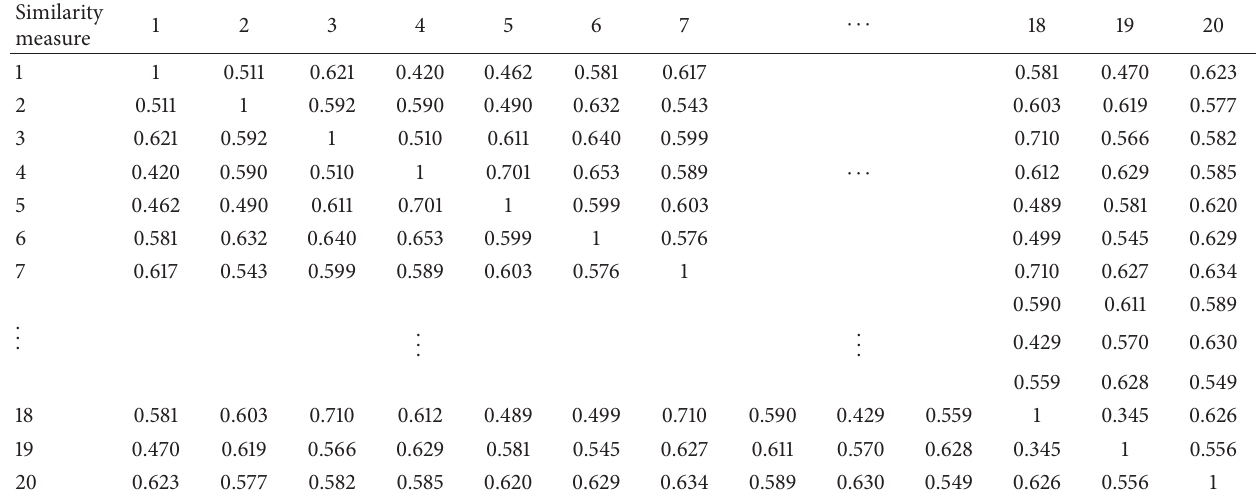
Table 3: Similarity measure comparison between individuals